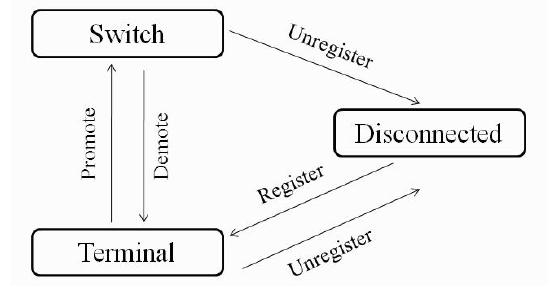
Figure 1. PRIME Service Node (SN) state machine [28].